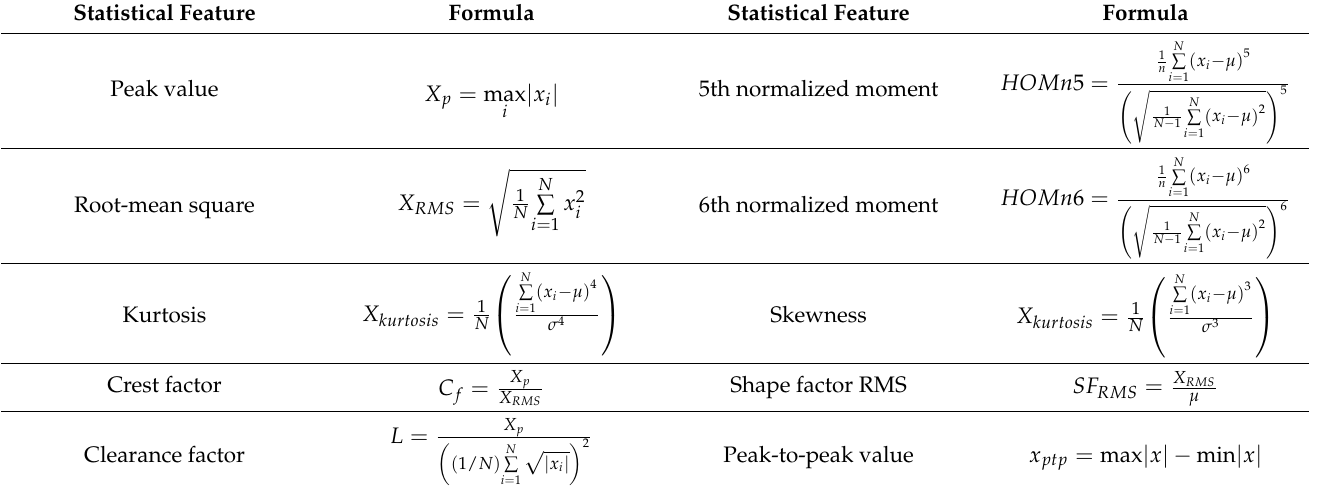
Table 8. Formulas of statistical features extracted from the vibration